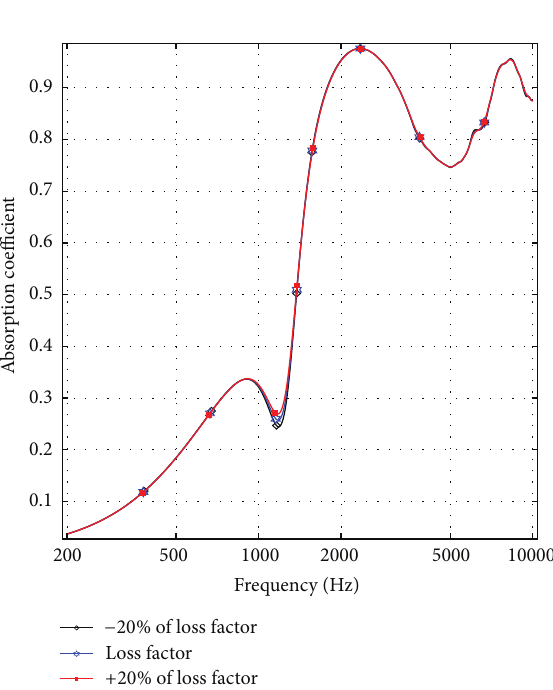
Figure 8: 𝜌 1 effects on absorption coefficient.